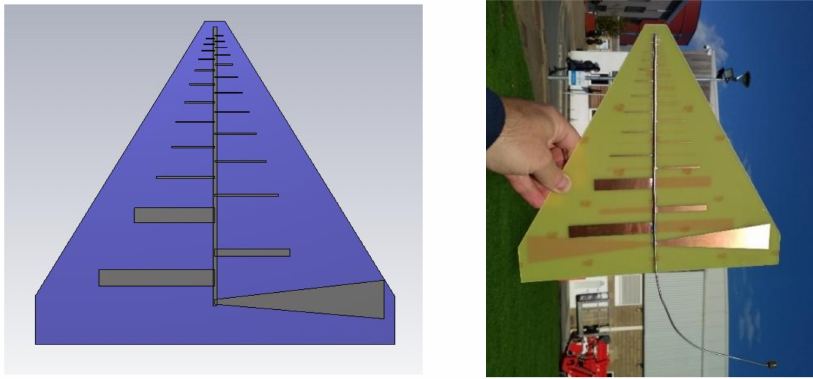
Figure 14. CST model of the proposed